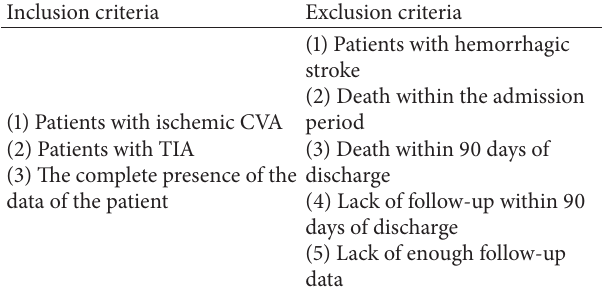
Table 1: Inclusion and exclusion criteria of study. Inclusion